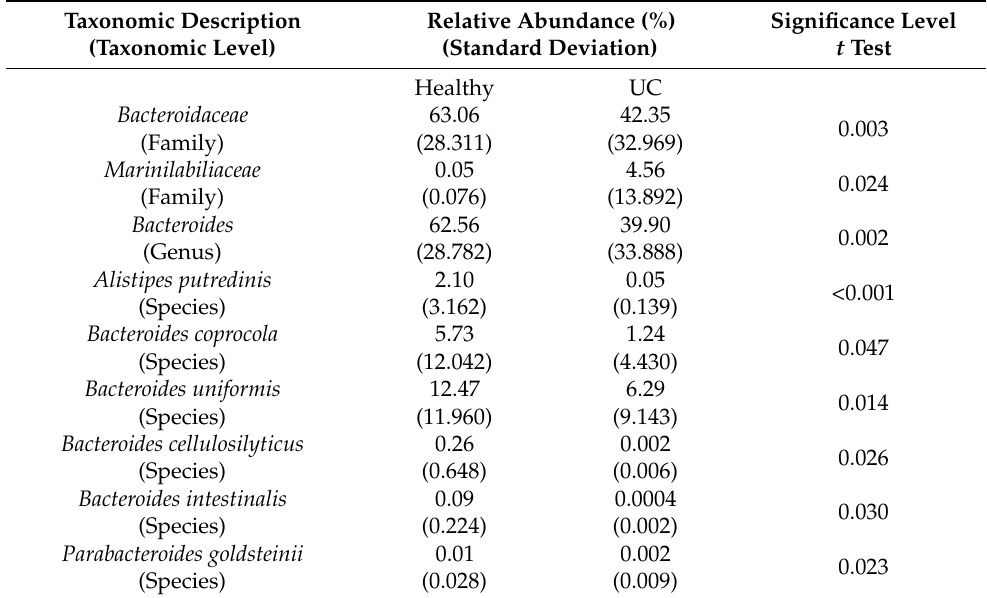
Table 2. Differences in the composition of order Bacteroidales between the healthy controls and UC